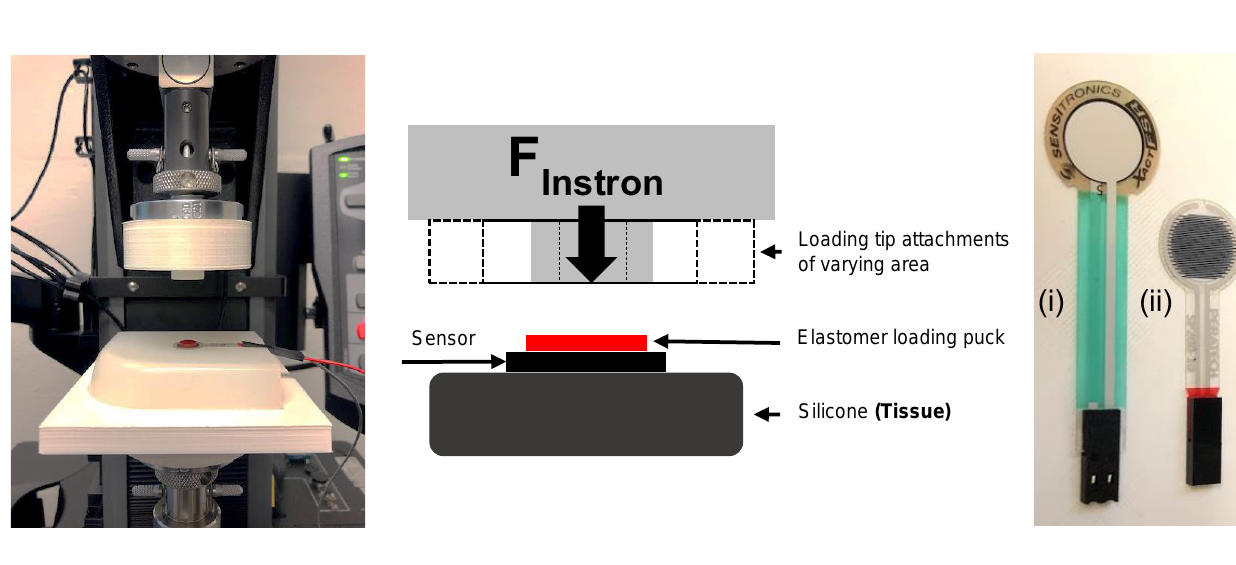
Figure 1: Actual setup, labelled schematic showing configuration with loading puck, and photo of sensors: (i) Sensitronics, (ii)